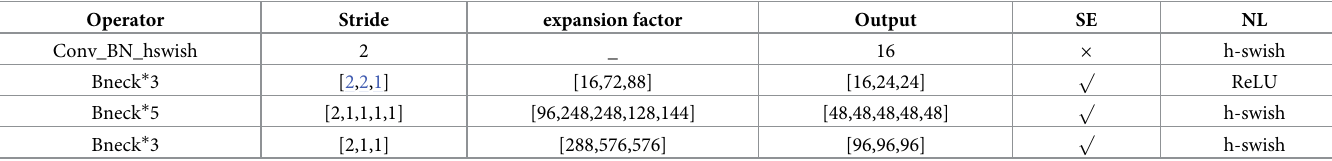
Table 1. The detailed structure of the backbone. Where the expansion factor represents the dimensionality of the first convolutional ascending dimension, SE represents the squeeze-and-excitation module, and NL represents the activation function type. Operator